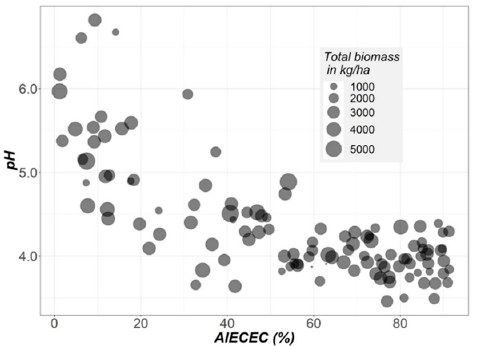
Figure 7. Relationship between soil pH, Al saturation of the effective cation exchange capacity (AlECEC) and total rye biomass.